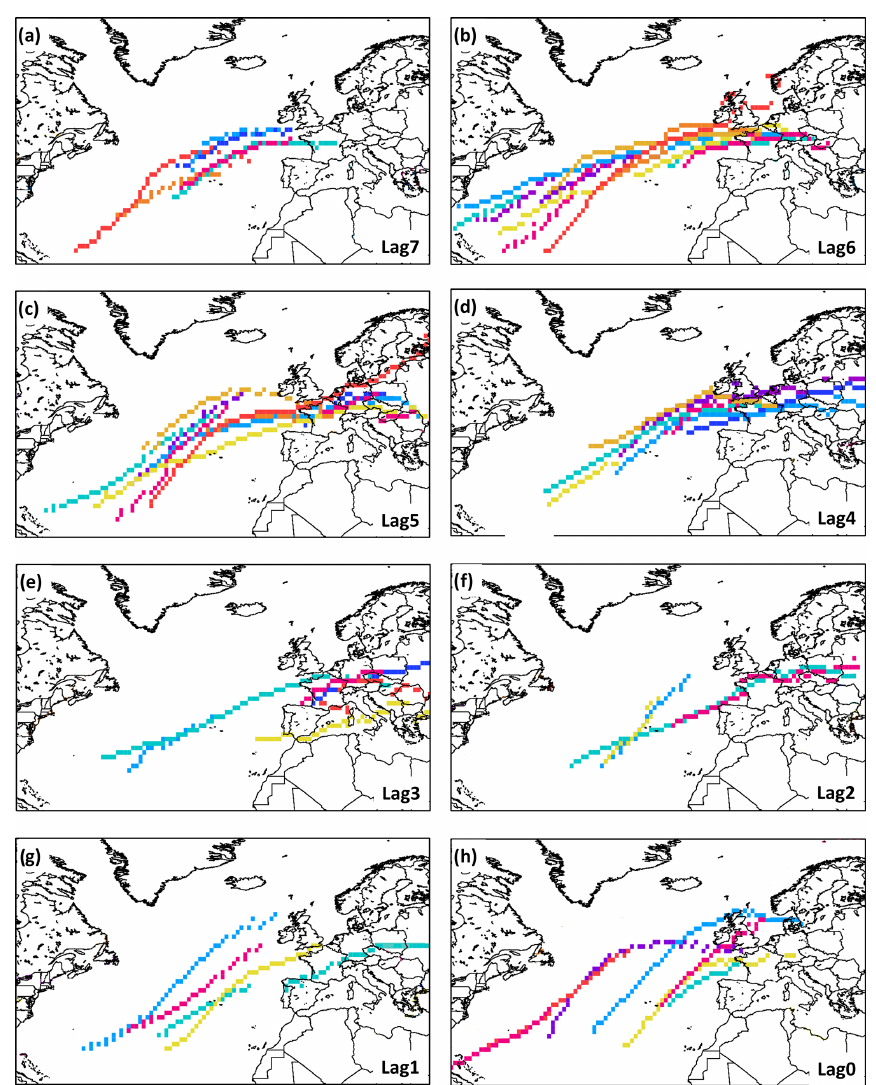
Figure 12. The AR axis location for the top 10 winter floods with different time lags (0–7d). Each color is assigned to a flood